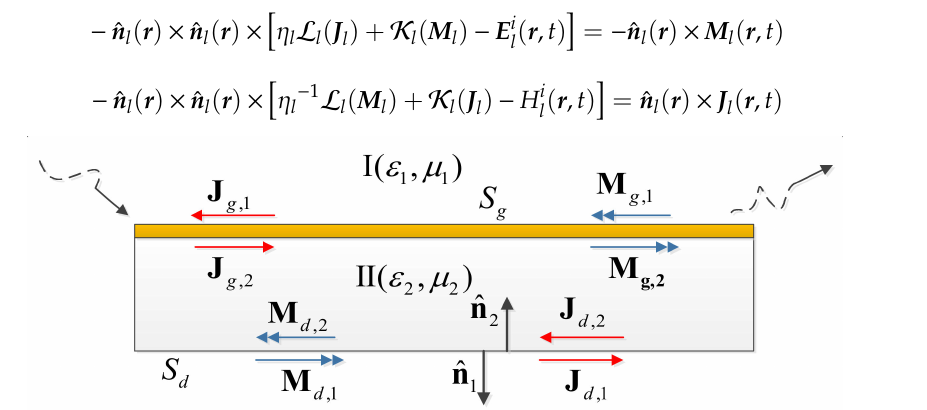
Figure 1. Graphene sheet with the dielectric